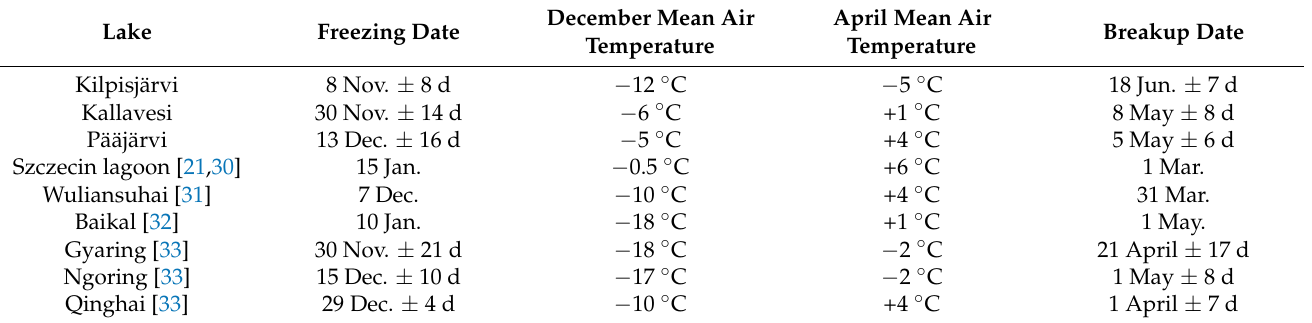
Table 2. Ice phenology in the selected Eurasian lakes. Notation ± nn refers to the standard deviation in days (d). The ice phenology data are based on the periods of 1960–2020 (Finland), 1991–2020 (China), 1896–2000 (Szcezin logoon), and 1960–2000 (Baikal), and the air temperature data are for the period of